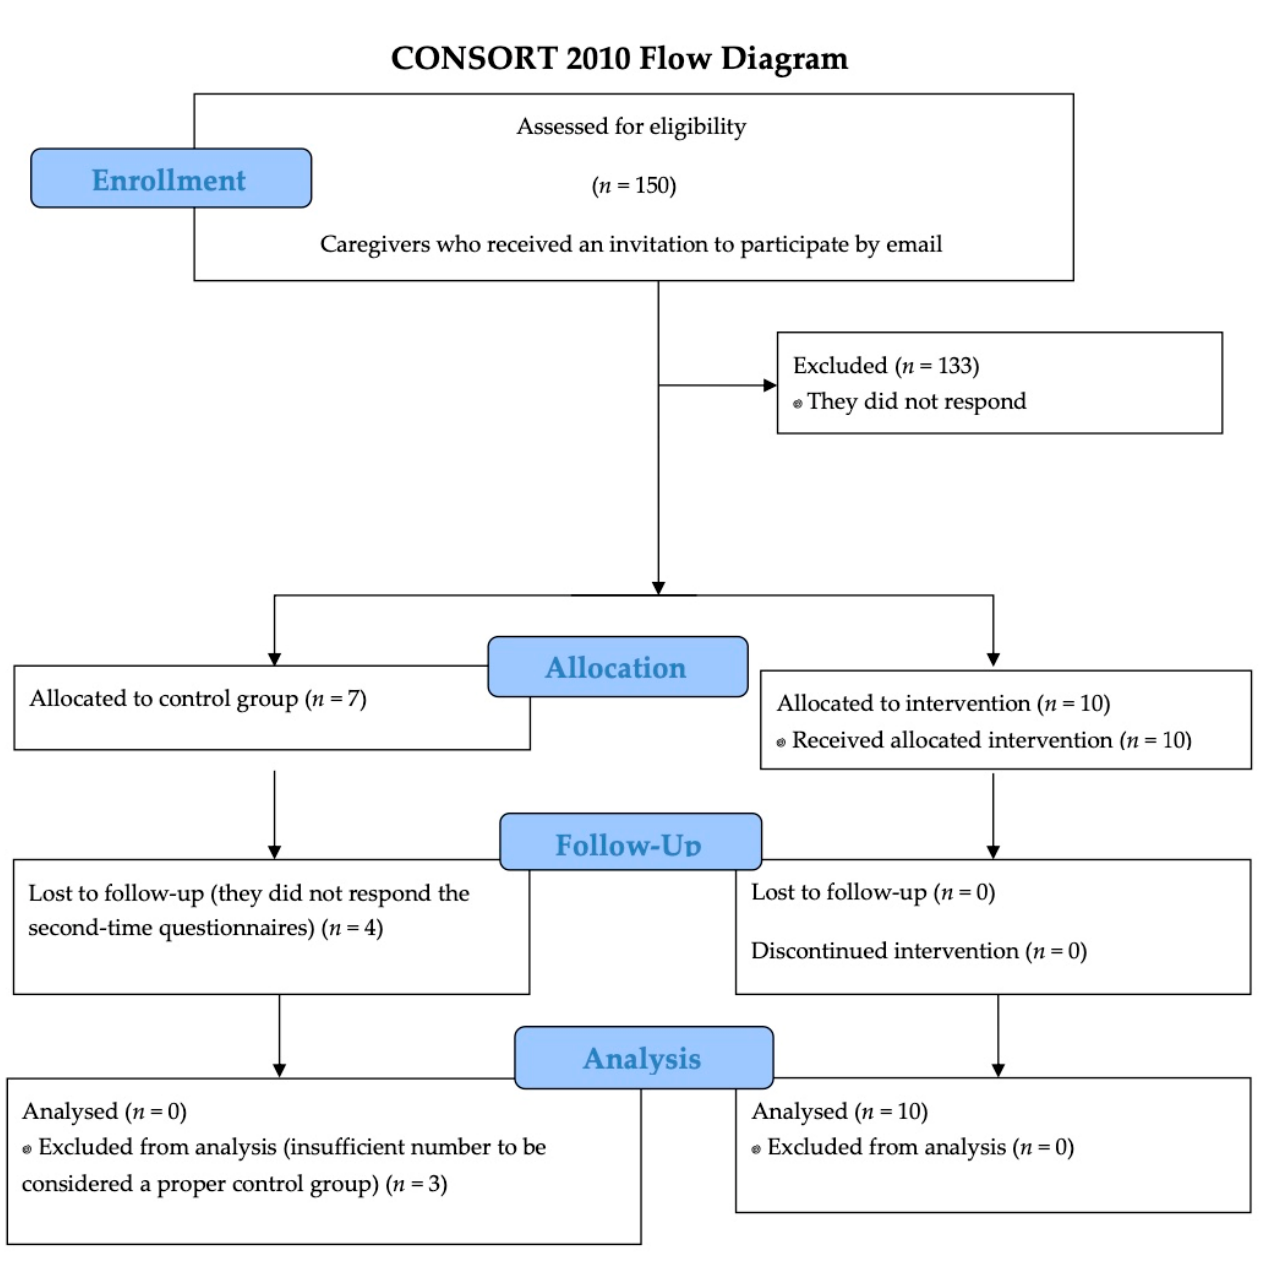
Figure 2. Consort Flow Diagram.